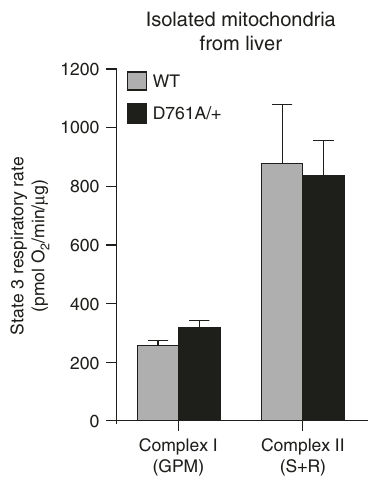
Fig. 7 Impact of Vps34 inactivation on respiration of isolated mitochondria. State 3 respiratory rate of freshly isolated mitochondria from liver, driven either by complex I (glutamate/pyruvate/malate) or complex II (succinate + rotenone). Data represent mean ± SEM of three